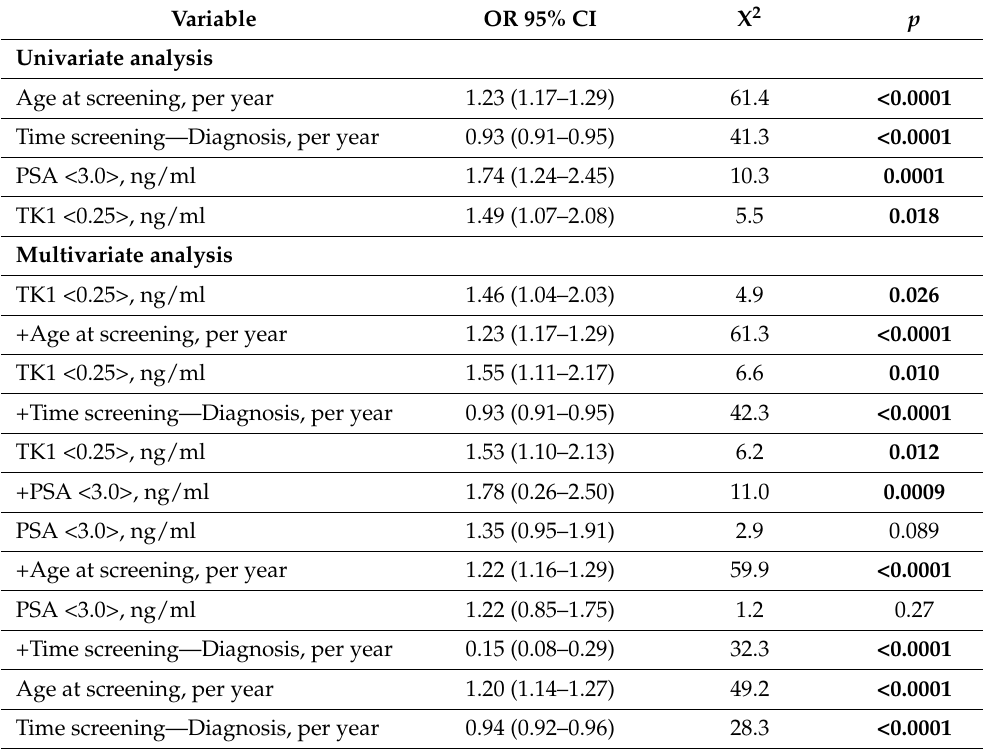
Table 2. Association between TK1 and PSA, age and time between screening and diagnosis of prostate